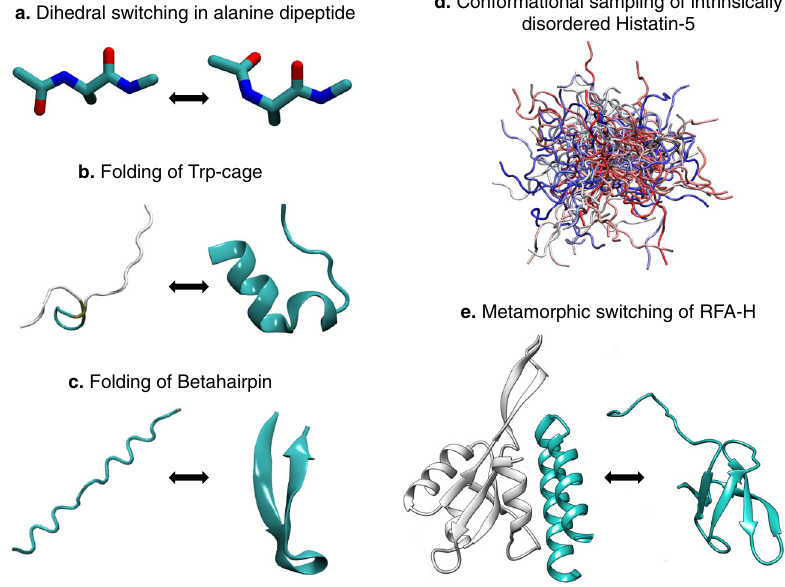
Fig. 1 List of systems studied. a Dihedral switching of alanine dipeptide, b folding of Trp-Cage from completely unfolded structure, c folding of β -hairpin, d intrinsically disordered Histatin-5, and e metamorphic switching in bacterial RFA-H are explored using the state-of-the art REST2 and the REHT approach designed in this work.